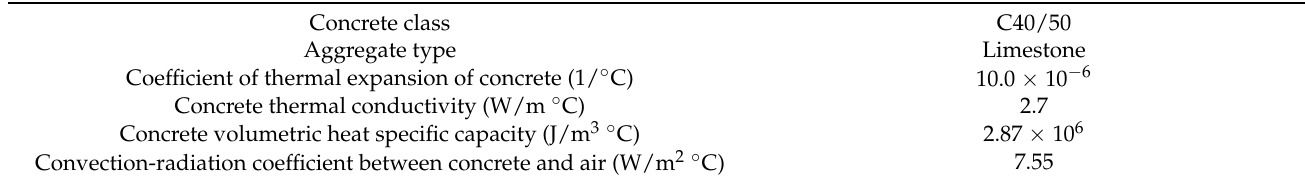
Table 3. Input parameters used in the finite element (FE) simulation.